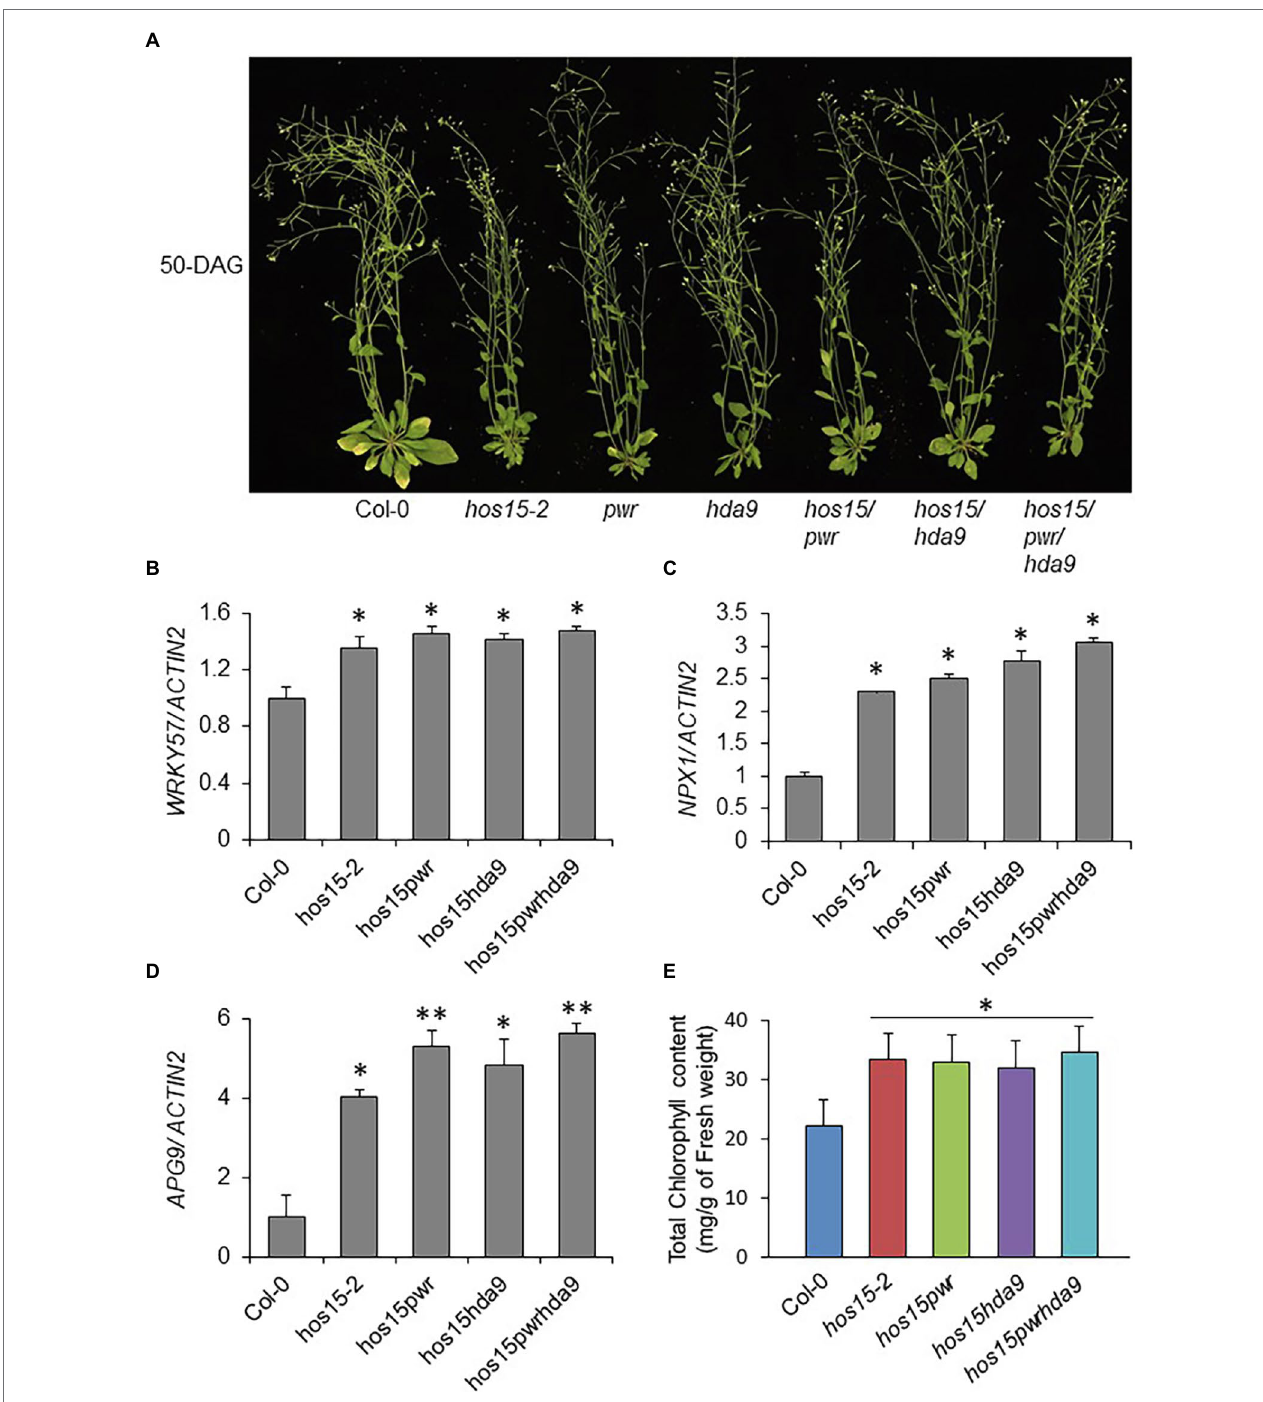
FIGURE 5 | HOS15-PWR-HDA9 complex promotes senescence through the regulation of same group genes. (A) Loss-of-function of HOS15-PWR-HDA9 complex components and its double and triple mutants showing late senescence phenotype after 50 days of germination. Seeds of Col-0, hos15-2, pwr, hda9, hos15pwr, hos15hda9 , and hos15pwrhda9 plants were grown on MS-media for 12 days and then transferred to soil. (B–D) The transcript analysis of senescence negative regulator genes, WRKY57, NPX1, and APG9 after 4 weeks of germination. Total RNA was extracted from the indicated genotypes and cDNAs were synthesized. The expression level was quantified using qRT-PCR. ACTIN2 was used as the internal control. Error bars represent SD from three biological replicates. Significant differences were determined via Student’s t -test (significance: * p < .05, ** p < .01). (E) Leaves of the 4-week-old plants of the indicated genotypes (3rd and 4th rosette) were used for measurement of total chlorophyll content. Error bars show SD. Significant differences were determined via Student’s t -test (significance: * p <